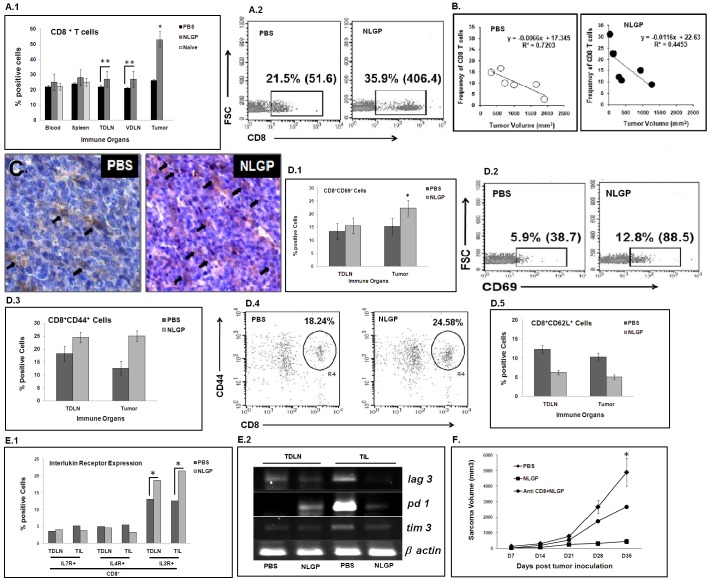
NLGP mediated tumor growth restriction and CD8+ T cells.Mice were inoculated with Sarcoma 180 tumor cells (1×106 cells/mice); after the formation of palpable tumor, mice were treated with NLGP (25 µg) once in a week, and four injections in total. A.1. Different immune organs (Blood, Spleen, TDLN, VDLN) and tumors were harvested on day 21 after initiation of therapy, lymphocytes were isolated, labeled with CD8-PE and percentage of CD8+ T cells were analyzed by flow cytometry, along with blood and spleen cells from naive mice. *p<0.001; **p<0.05. A.2. Representative dot plots of CD8 positivity of TILs harvested from tumor of PBS- and NLGP-treated mice. B. Tumor volume of PBS- and NLGP-treated mice was plotted against percentage of CD8+ cells. C. Presence of CD8+ T cells was detected on cryosections of tumor tissues from either PBS or day 21 NLGP-treated mice by immunohistochemistry. D.1. MNCs from TDLN and tumors were harvested from mice with day 21 tumors and stained for CD8+CD69+. *p<0.05. D.2. CD8+ cells within MNCs of PBS- and NLGP-treated mice were gated and CD69+ cells were identified within this gated population as presented by dot plots. D.3. MNCs from TDLN and tumors were harvested from mice with day 21 tumors and stained for CD8+CD44+. D.4. A representative dot plot for CD8+CD44+ cells within MNCs of PBS- and NLGP-treated mice. D.5. MNCs from TDLN and tumors were harvested from mice with day 21 tumors and stained for CD8+CD62L+ cells. E.1. Expression of cytokine receptors, like, IL-7R, IL-4R and IL-2R, on cells from TDLN and TIL of NLGP-treated mice was determined flow cytometrically. E.2. Expression of T cell exhaustion markers, like, lag3, pd1 and tim3, in cells from TDLN and TIL of NLGP-treated mice was determined at transcriptional level by RT-PCR. F. CD8+ cells were depleted in NLGP-treated mice, along with PBS (negative) and NLGP (positive) treatment into two other groups as controls. Tumor growth curve is presented. *p<0.001, in comparison to NLGP-treated group.